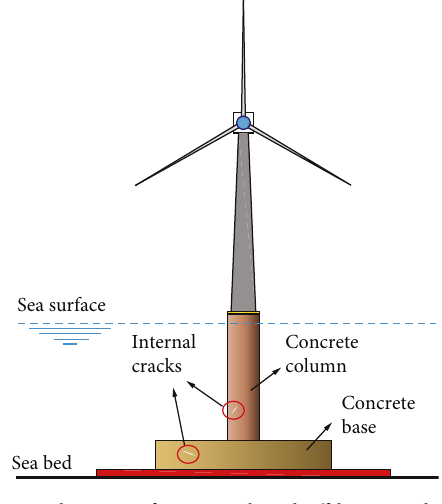
Figure 2: Schematic of a gravity-based o ff shore wind